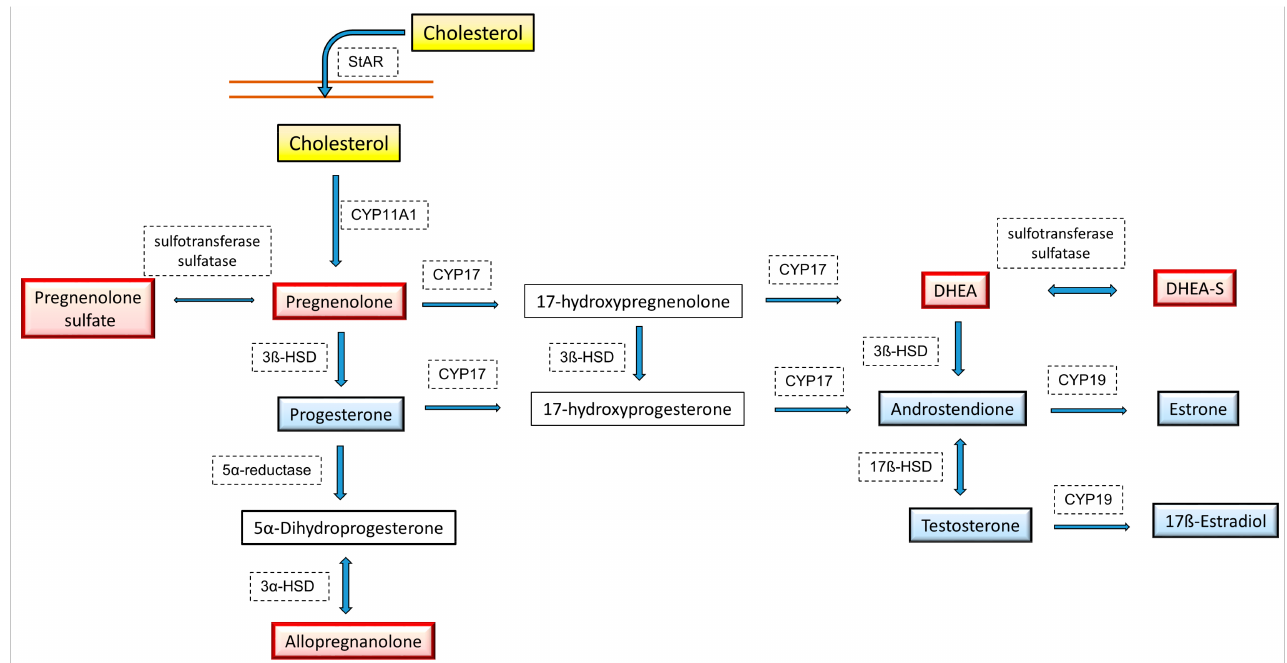
Figure 3. A simplified diagram of the synthesis of steroid hormones and neurosteroids. DHEA—dehydroepiandrosterone; DHEA-S—dehydroepiandrosterone sulfate; CYP11A1—mitochondrial cholesterol side-chain cleavage enzyme; StAR— steroidogenic acute-regulatory protein; 3 β -HSD—3 β -hydroxysteroid dehydrogenase; CYP17-hydroxylase/17,20-lyase; CYP19—aromatase; 17 β -HSD—17 β -hydroxysteroid dehydrogenases; 3 α -HSD—3 α -hydroxysteroid oxidoreductase. Sex steroids are presented in blue boxes whereas neurosteroids are featured in red